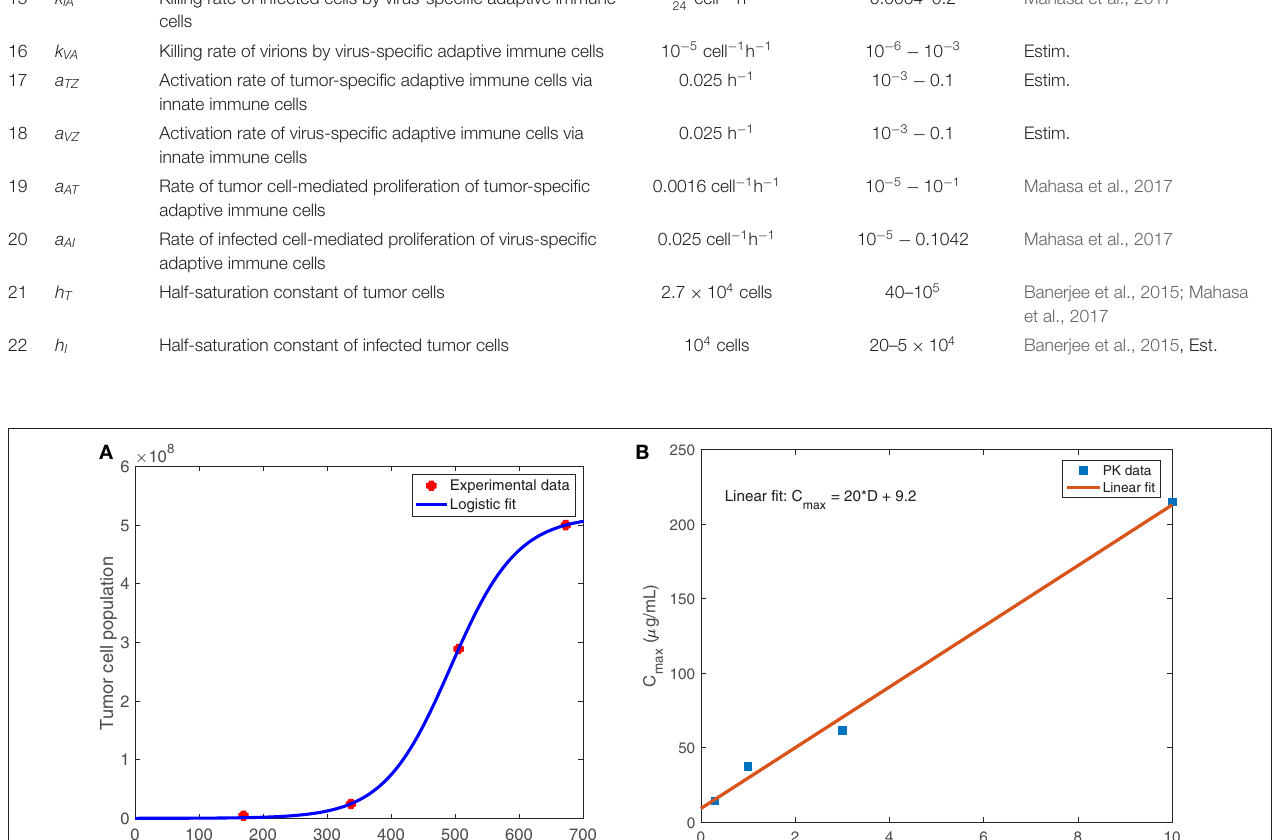
Frontiers in Physiology |